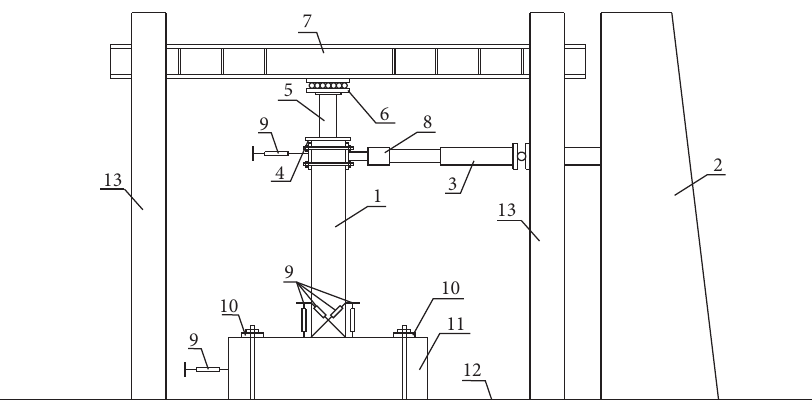
Figure 4: Setup for the loading tests. (1) Column specimen; (2) reaction wall; (3) hydraulic actuator; (4) lateral load transfer assembly; (5) hydraulic jack; (6) sliding support; (7) reaction beam; (8) sensor; (9) LVDTs; (10) anchoring screws; (11) foundation beam; (12) strong floor; (13) gantry.